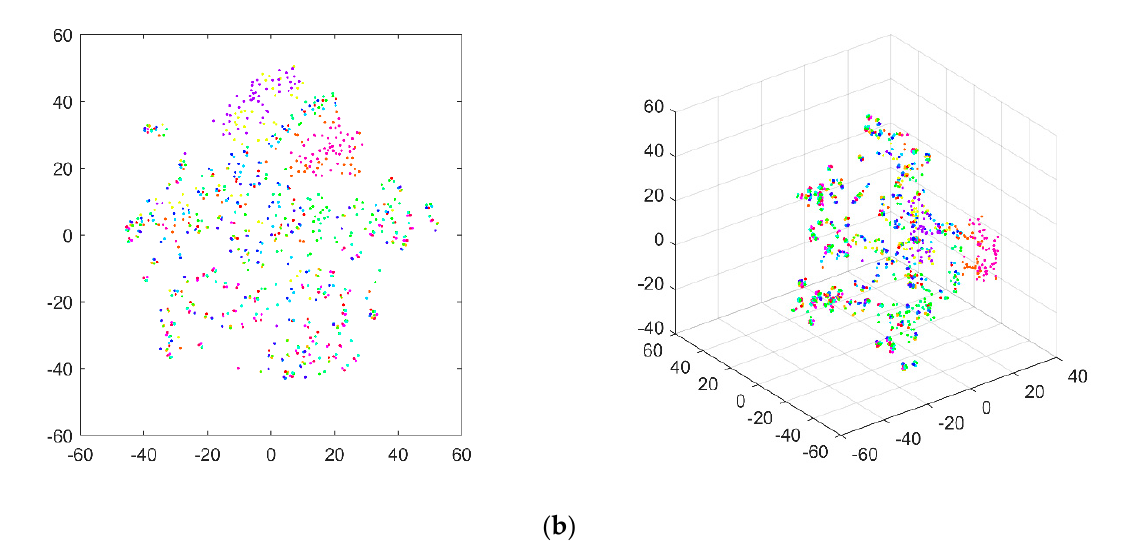
Figure 12. Visualization results of signal features in the ( a ) TS and ( b ) FFT-based signals extracted by the 1D CNN model.